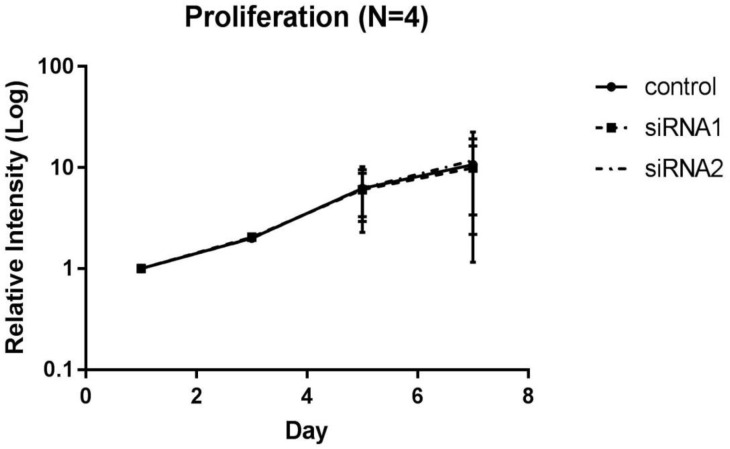
Proliferation assay in BAP1 knockdown GBC cell line.BAP1 expression of the GBC cell line G-415 was down-regulated by siRNA and the proliferative ability was measured by MTS assay. No significant difference was observed between each siRNA group and the control. The vertical axis shows the relative intensity compared to the intensity at day 1, and the horizontal axis shows the number of cell culture days.